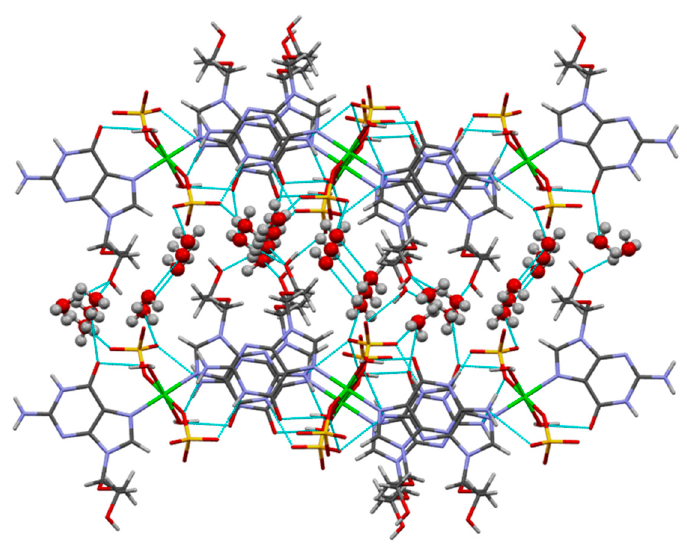
Figure A4. Many H-bonds, some of them involving H 3 O+ ions, H 2 O molecules, and acv-O(ol)H groups as H-donors, linking the π , π -stacked 2D-layers in a 3D array in the crystal of compound 1 .